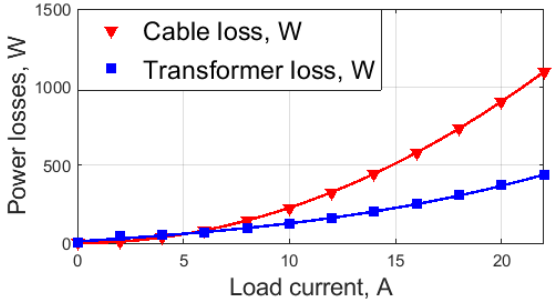
Figure 6. Cable and transformer losses depending on the load current.